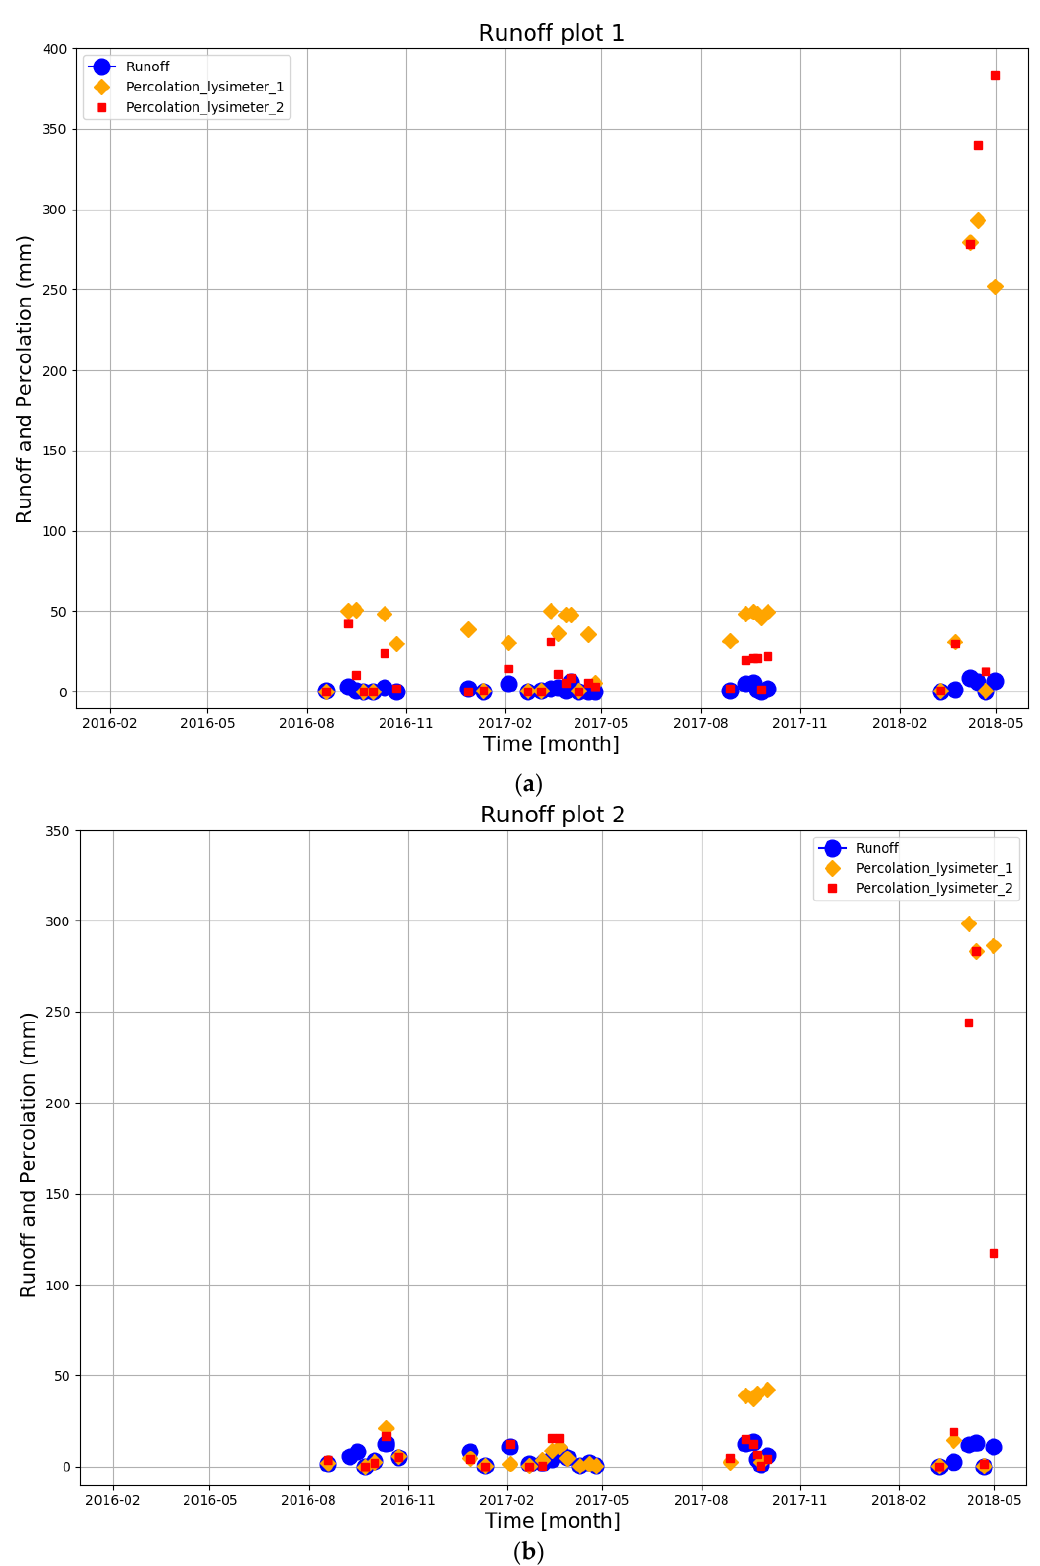
Figure 5. Runoff and lysimeter measurements in the two plots (plot locations are in Figure 1). ( a ) Runoff plot 1; ( b ) Runoff plot 2. plot 1; ( b ) Runoff plot